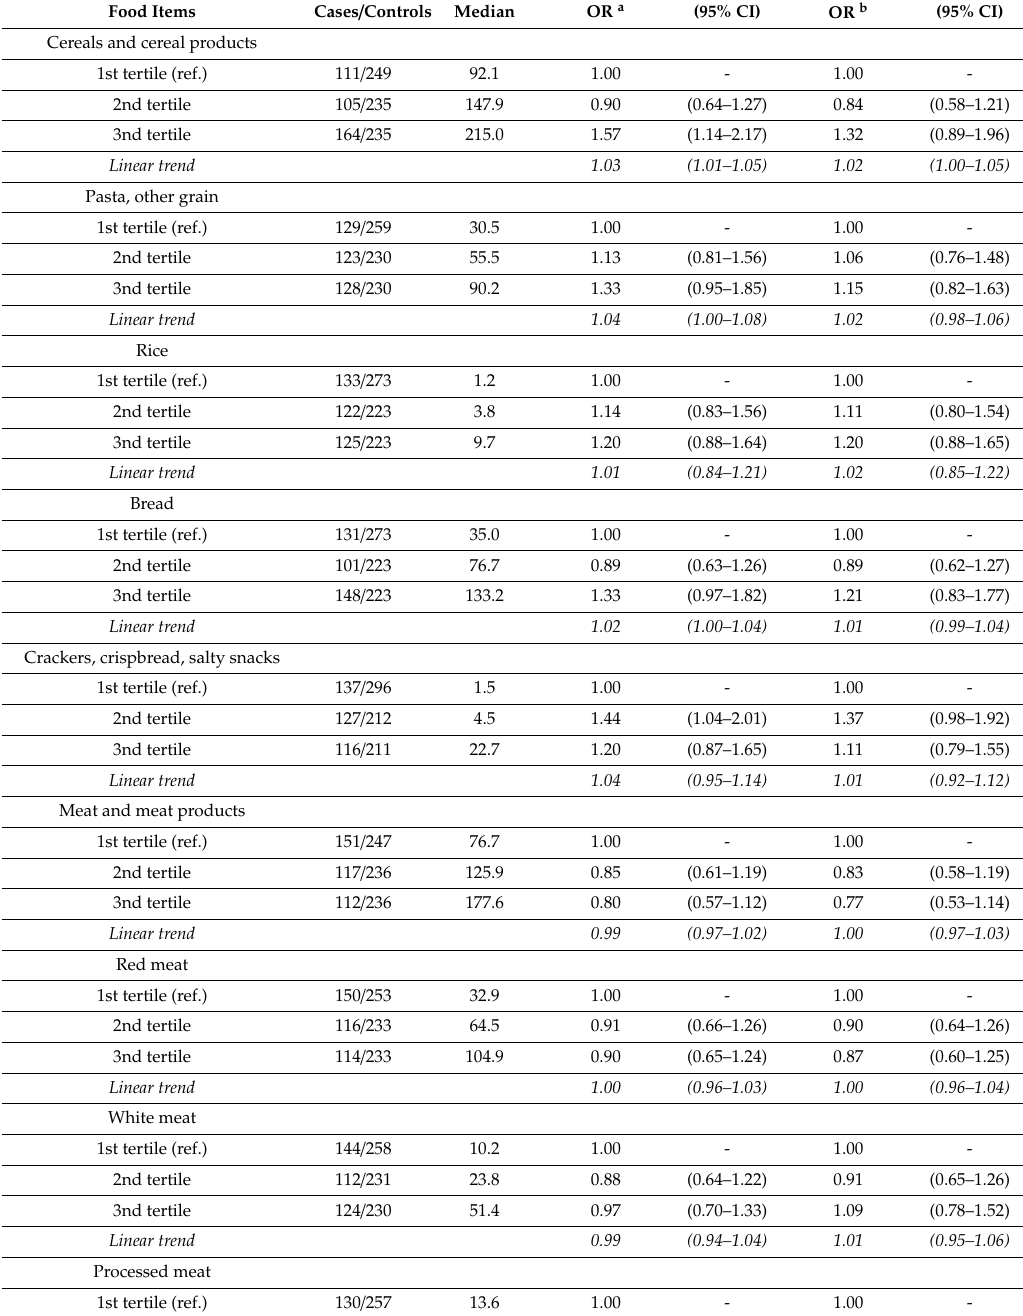
Table 3. Overall odds ratios (OR) and 95% confidence intervals (CI) for developing cutaneous malignant melanoma according to tertiles of daily intake (residual of regression on energy), obtained from conditional multiple logistic regression models. Linear trend for 10-g increments of daily